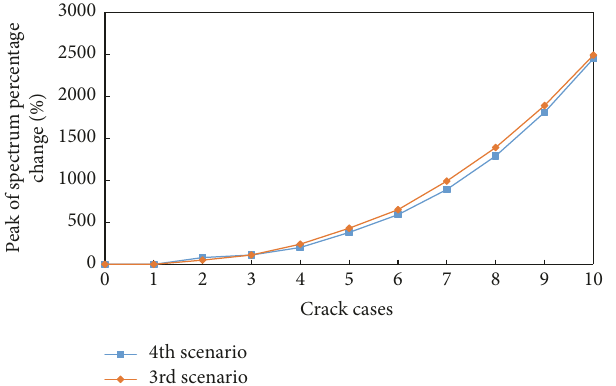
Figure 47: Percentage change in the peak of the residual signal spectra for the third and fourth